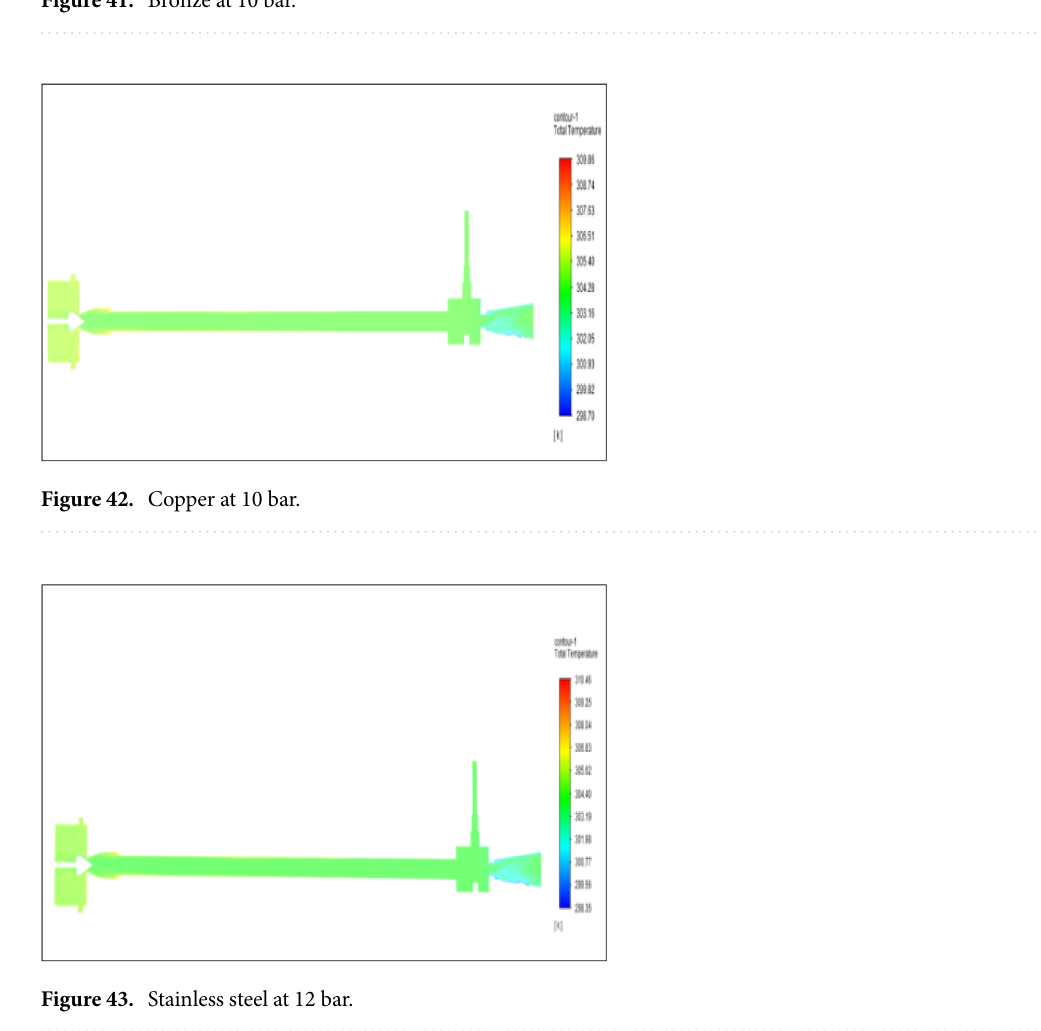
Figure 41. Bronze at 10 bar.